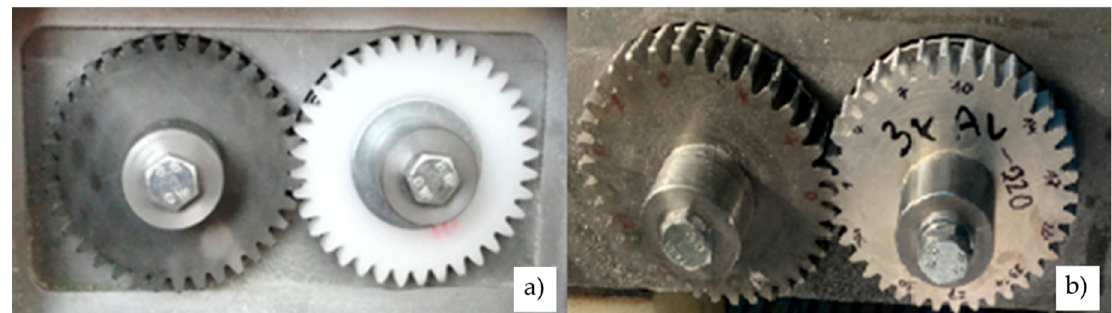
Figure 3. Tested polymer gear made of POM: ( a ) Without coating, ( b ) Al coating.